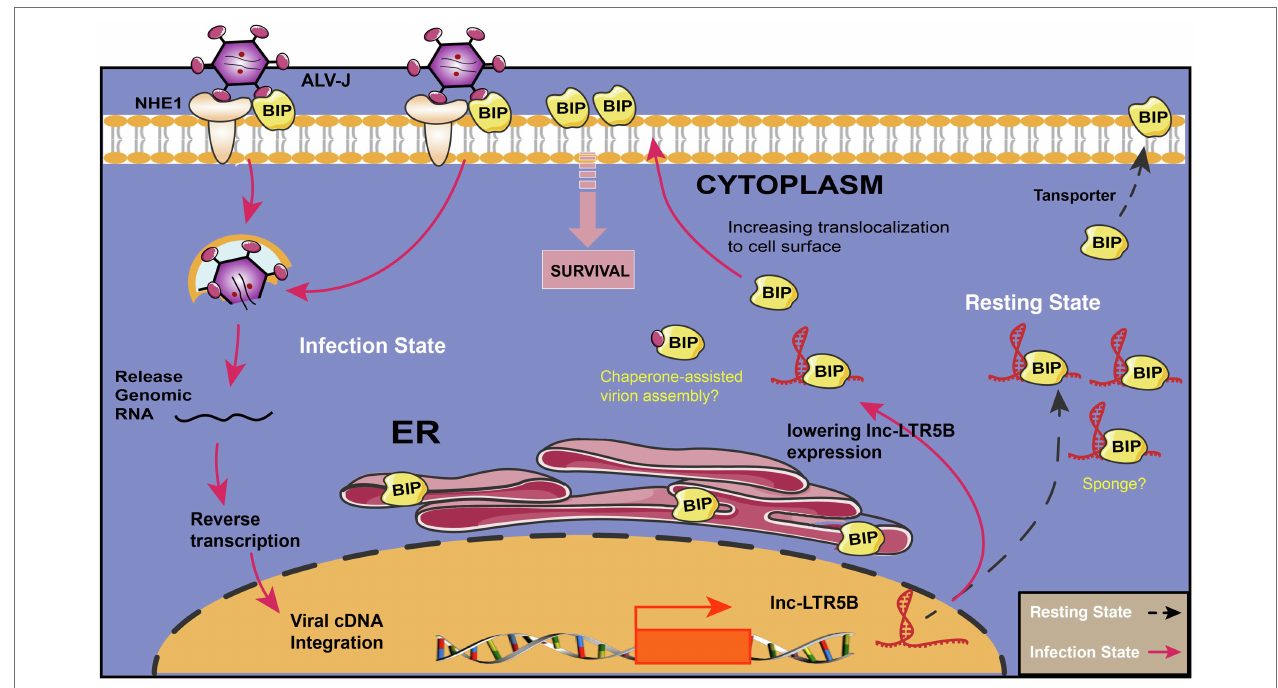
FIGURE 7 | Schematic diagram showing the proposed mechanism for the effects of lnc-LTR5B on regulating ALV-J infection via BiP. In resetting cells, lnc-LTR5B localizes in the cytoplasm where it is abundant and binds free BiP to control cell homeostasis. Upon ALV-J infection, lnc-LTR5B expression is reduced, which favors the dissociation of BiP from its binding state, allowing its translocation to the cell surface, which is crucial for ALV-J entry as well as pro-survival